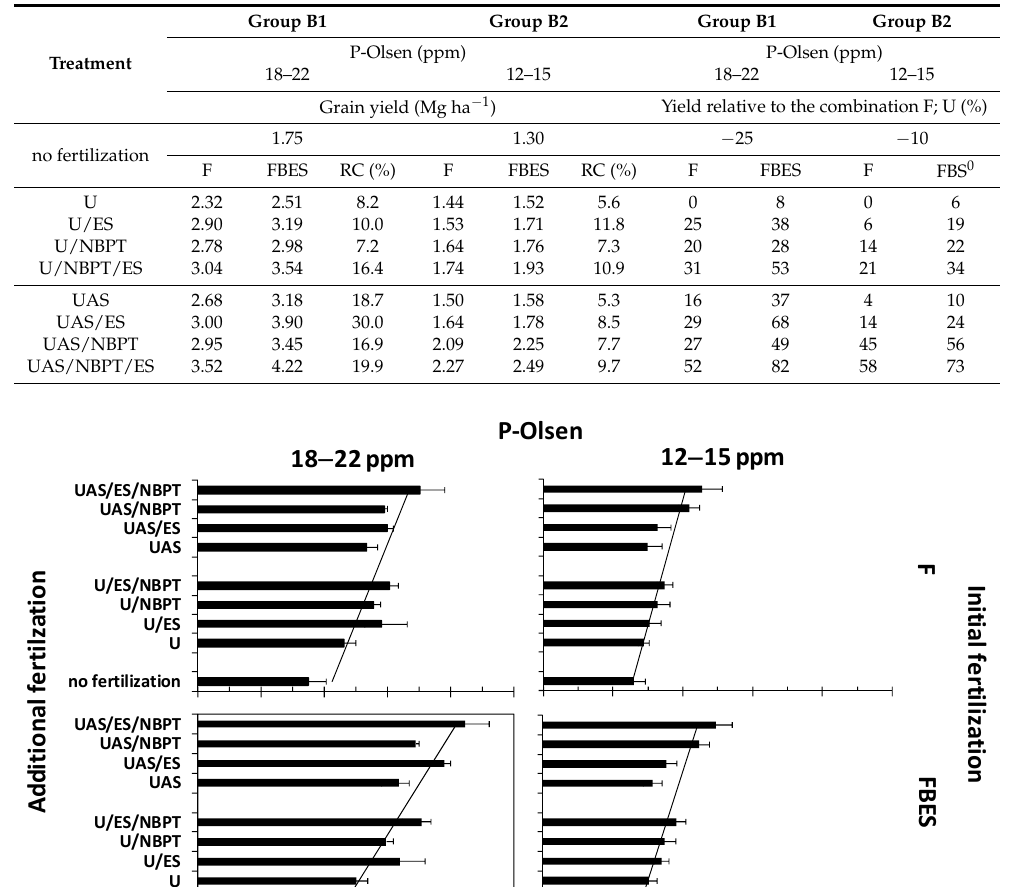
Table 3. Results of the randomized plot experiments of 2016–2017 growing season (Group B). F (16-20-0) or FBES (16+20-0+2%ES): Initial fertilization (F1) along with sowing, U, urea 46-0-0; UAS, urea plus ammonium sulfate 40-0-0. “/NBPT” denotes fertilizer with NBPT (N-(n-butyl) thiophosphoric triamide; urease inhibitor). “/ES” denotes fertilizer with 2% elemental sulfur. “/NBPT/ES” denotes application of a 50:50 mixture of fertilizer with NBPT and the same fertilizer with 2% elemental sulfur. The F; U trial served as a reference, with rates of F1 and F2 (additional fertilizer application) 250 kg ha − 1 respectively. Simeto cultivar was used.